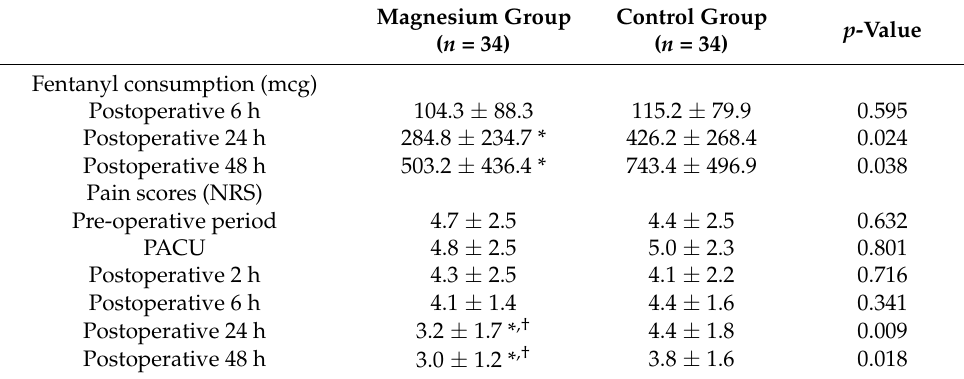
Table 2. Cumulative fentanyl consumption and pain scores during the first 48 h after surgery.